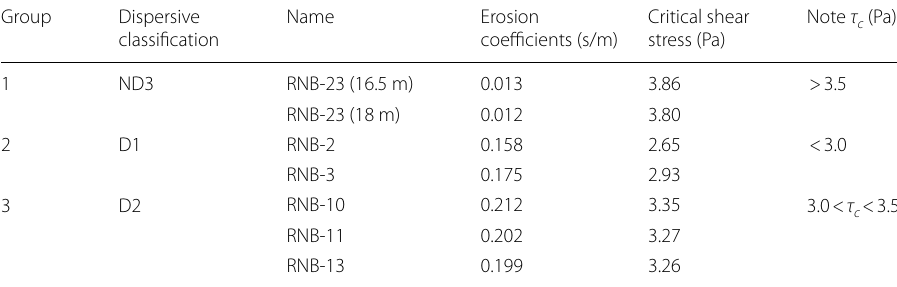
Table 2 Dispersive classification and critical shear stress of soils Group Dispersive Name Erosion classification